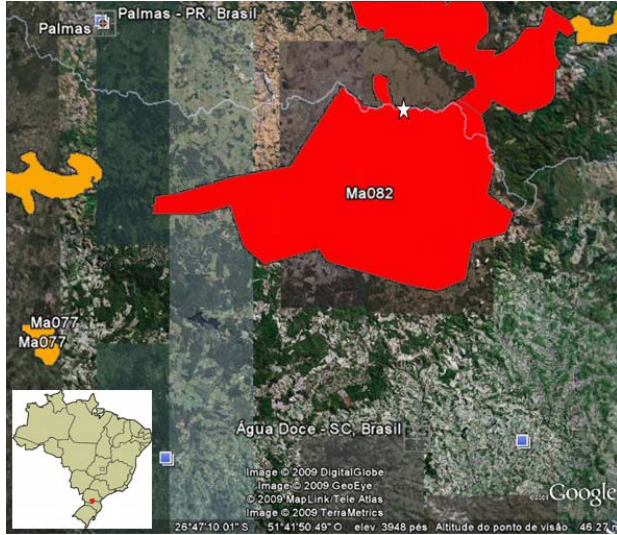
Figure 3. Phyllomedusa azurea The new record of (star), located in an area with high priority for conservation in the Atlantic Forest biome (Ma082: Campos de Água Doce) according to the Brazilian Environmental Ministry (MMA 2007).